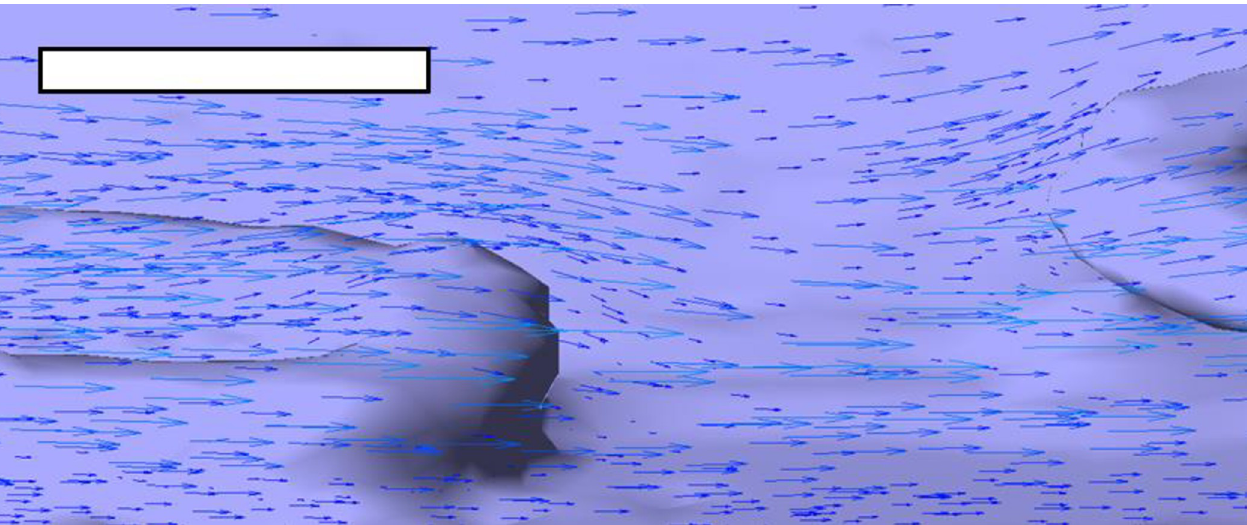
Fig 7. Velocity vectors around coronary stent struts. In silico models were reconstructed from Coroflex Blue stent strut μ CT data and used for CFD analysis. Velocity fields are depicted at the vessel wall [dark blue arrows] and at a fluid layer positioned nearer to the lumen [light blue arrows], with the length of each arrow being proportional to velocity. Vectors revealed that while stent struts had relatively modest effects on velocity magnitude, they greatly impacted direction as flow moved up and over struts, leading to reduced wall shear stress in those regions. Flow from left to right, 1 Pa average wall shear stress. Scale bar: 100 μ